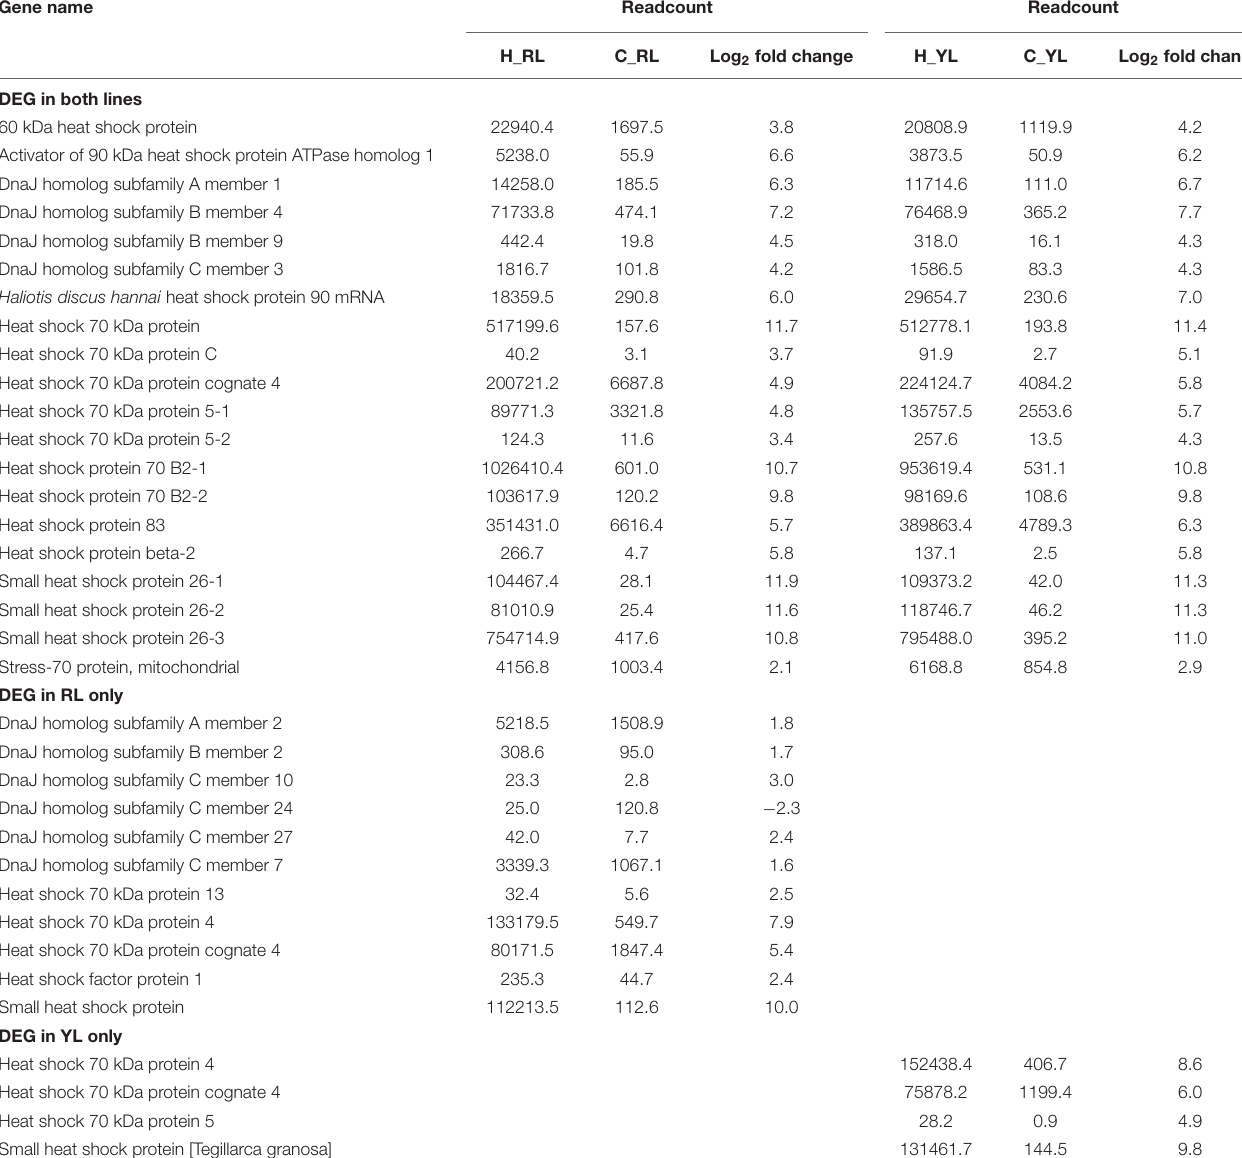
TABLE 1 | Differentially expressed heat shock protein family